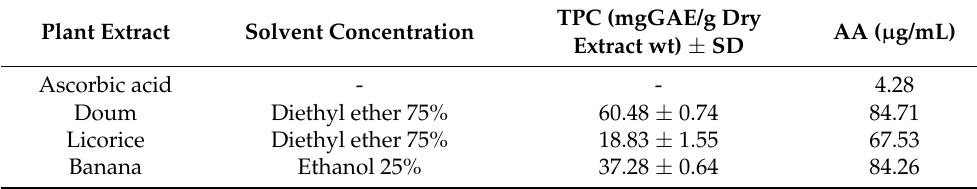
Table 6. Total phenolic contents (TPC) and antioxidant activity (AA) of the tested plants.